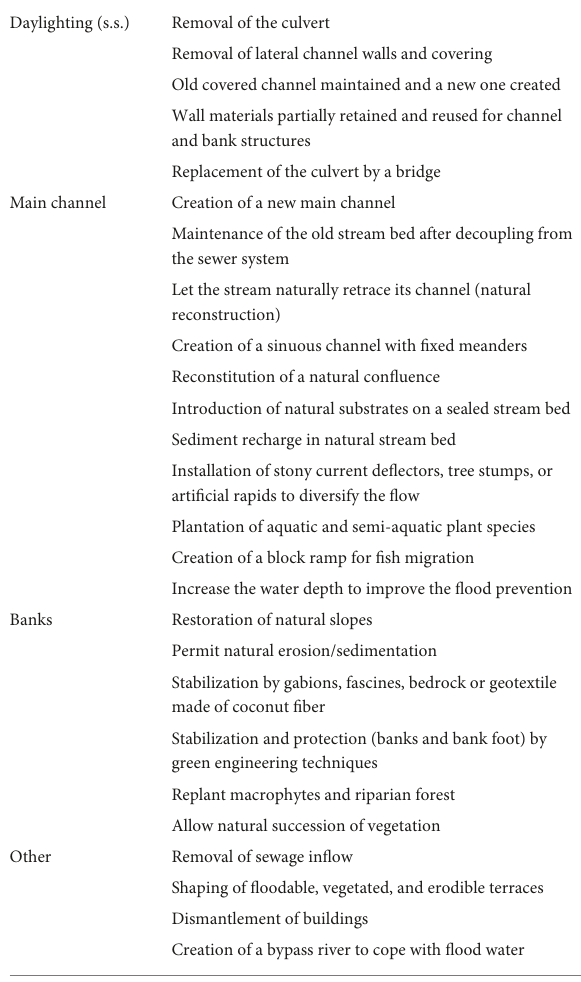
TABLE 2 Types of actions performed during the daylighting of streams in the case studies. Type of actions